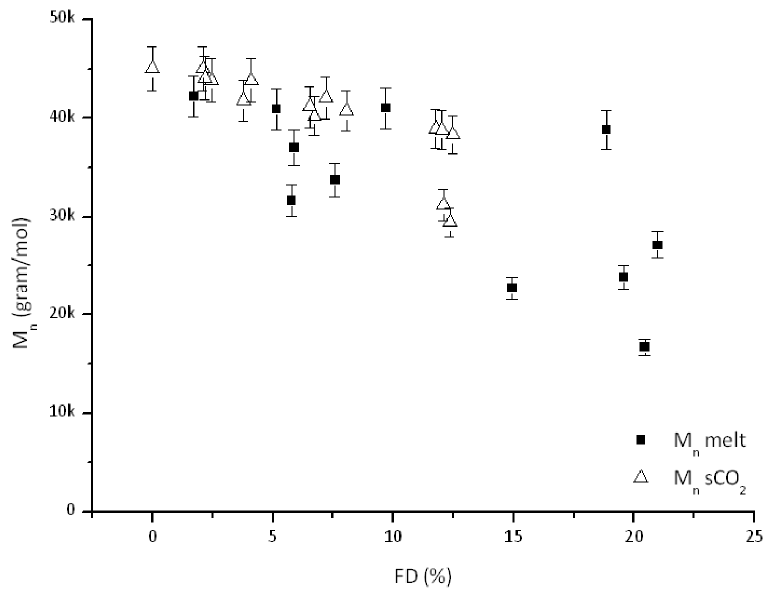
Figure 8. M n comparison of reactive interfacial agents made in melt and scCO 2.